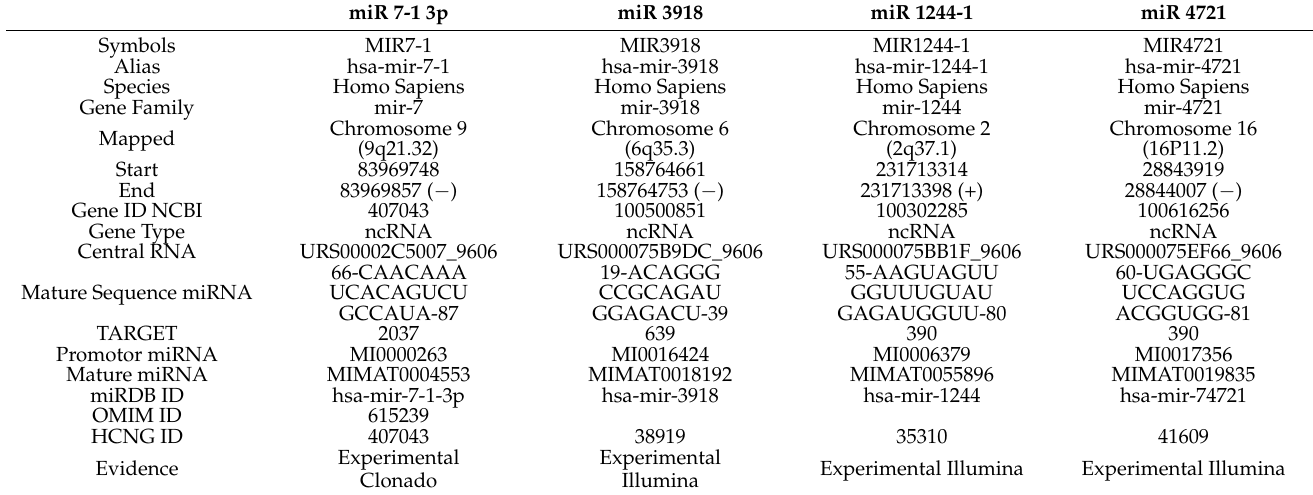
Table 2. Hypermethylated miRNA by MedIP-seq.